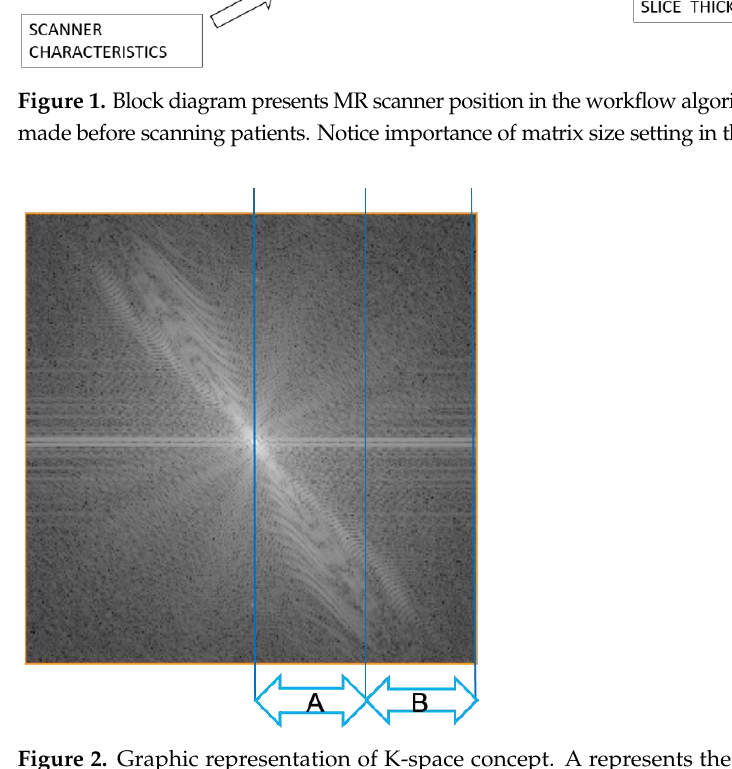
Figure 2. Graphic representation of K-space concept. A represents the center of the K-space area where the signal strength is encoded. B indicates the K-space periphery and presents the encoded spatial information of the image. A gradient frequency modulates the alignment of the signal, and it is set by the MR machine operator when the image acquisition matrix is selected.